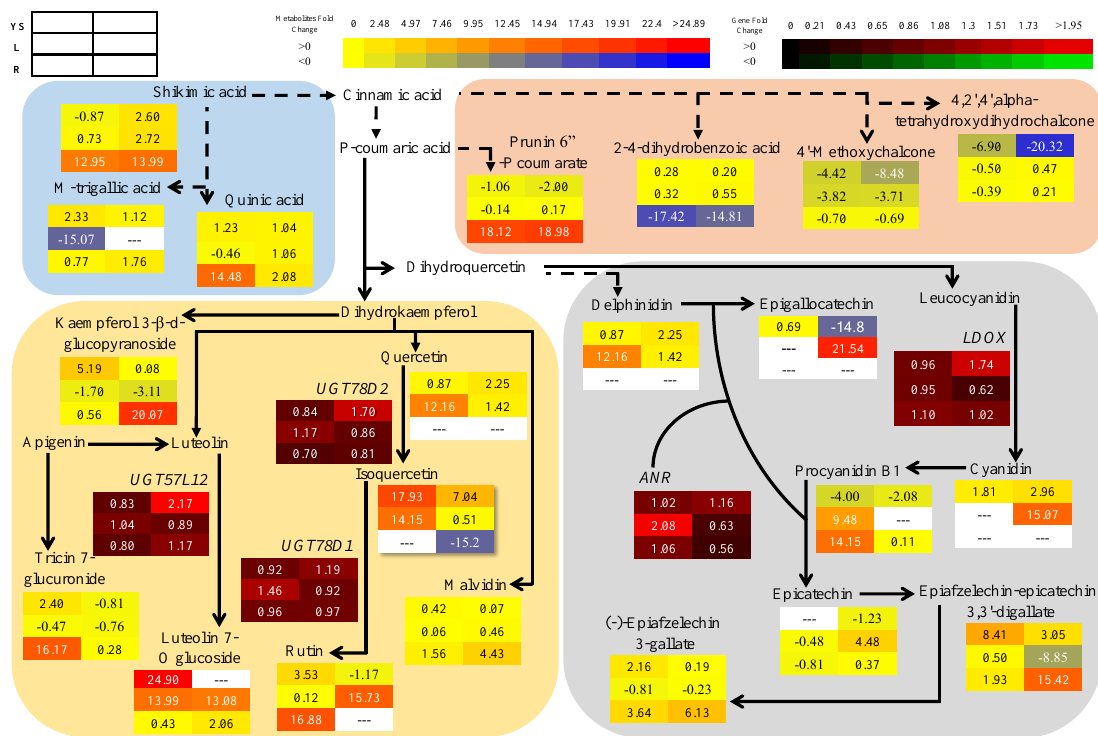
Figure 2. Fold change (log 2[ − P/+P] ) of secondary metabolites and metabolic genes in response to P starvation. Fengqing ( left column ) and Longjing-43 ( right column ) and from the top to the bottom rows are young shoots ( first row ), leaves ( middle row ) and root ( button row ). YS, L and R represents young shoots, leaves, and root, respectively. Metabolites and metabolic genes inside background color box represents different biosynthesis pathway. The solid arrow shows direct and dotted arrow represents speculated steps in the pathway. The data depicted from Table S2 and Table 5, positive as increase and negative as decrease in fold change. On the false color scale red indicates increase; blue and green indicates decrease in metabolites and gene. ANR , anthocyanin reductase ; LDOX , leucoanthocyanidin dioxygenase ; UGT57L12 , flavanol 7-O glycosyltransferase ; UGT78D2 , flavanol 3-O-glucosyltransferase 2 ; UGT78D1 , flavanol 3-O-glycoside L-rhamnosyl transferase 1